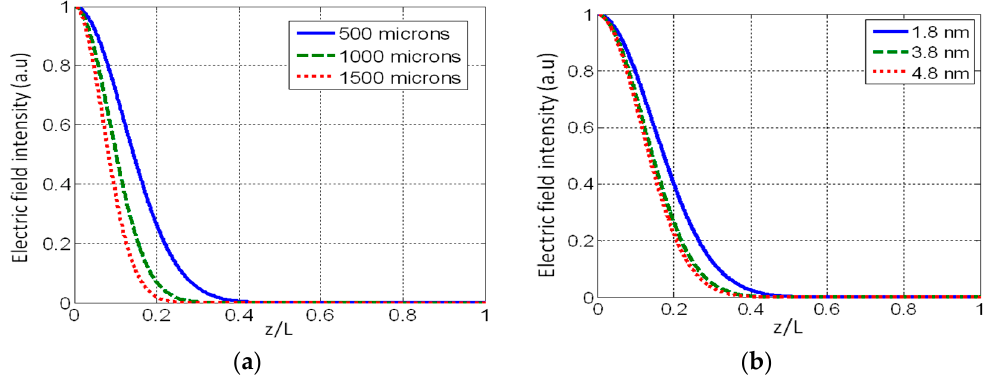
Figure 3. ( a ) The electric field intensity distribution along the length of the resonators with ∆ r co = 3.8 nm and L = 500, 1000, and 1500 μ m; ( b ) the electric field intensity distribution along the length of the resonators with ∆ r c o = 1.8, 2.8, and 3.8 nm and L = 500 μ m. n cl = 1.33.